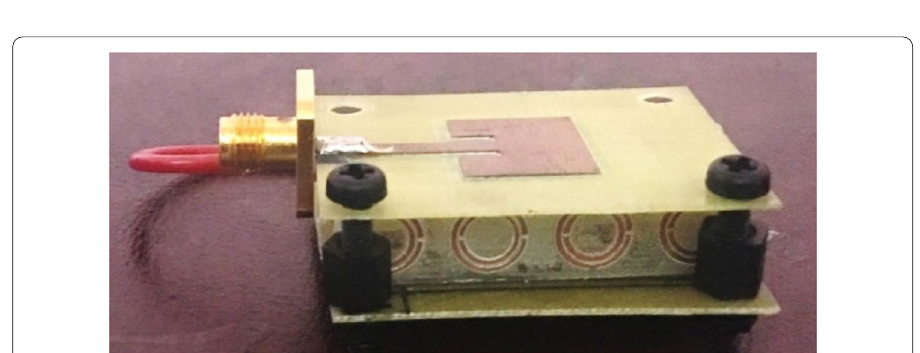
Fig. 11 Fabricated proposed antenna with metamaterial layers placed under